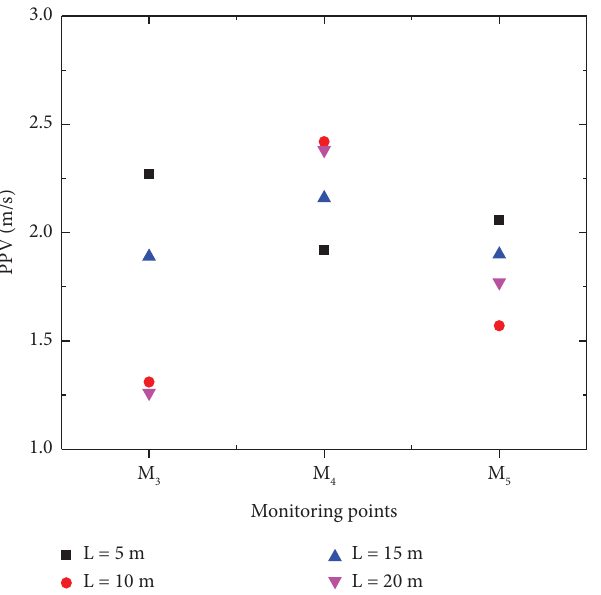
Figure 8: PPV on measuring points of blasting with a vibration- isolating slot with diferent positions.